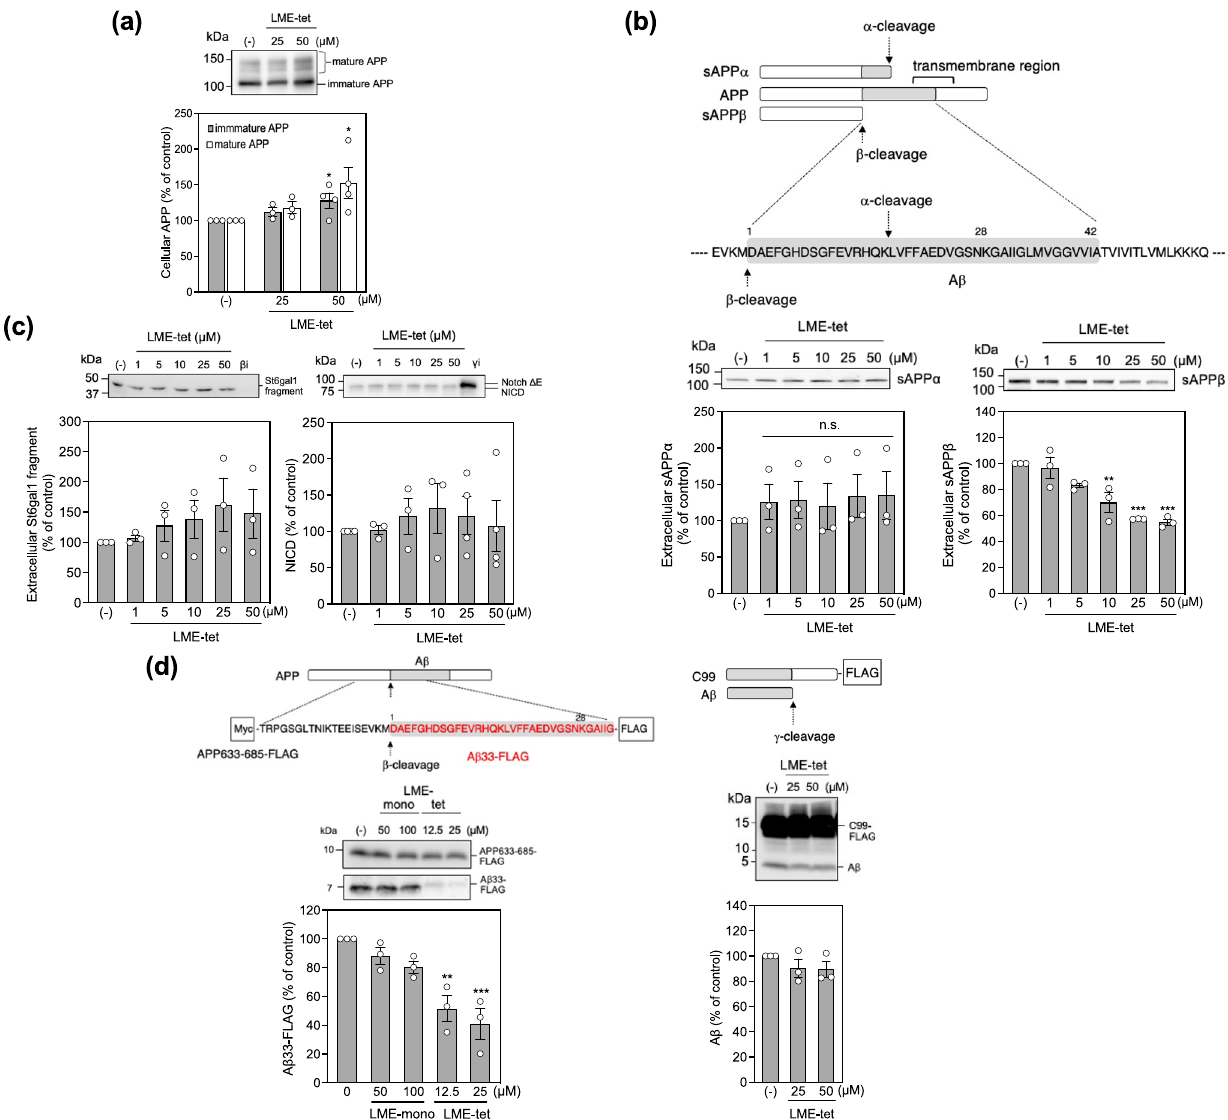
Fig. 4 LME-tet speci fi cally inhibits β -secretase to block production of A β . a Effect of LME-tet on APP production. 7WD10 cells were treated with vehicle control or LME-tet at the indicated concentrations for 48 h. Cell lysates were analyzed by western blot. b Effect of LME-tet on production of extracellular sAPP α and sAPP β Schematic showing α - and β -cleavage sites (top). 7WD10 cells were treated as in ( a ) and sAPP α and sAPP β in culture medium were analyzed by western blot (bottom left and right panels, respectively). a , b APP and sAPP α were detected using anti-APP antibody 6E10, and sAPP β was detected using anti-sAPP β antibody. Data are graphed as the percentage of the control value, showing the mean ± SE; n = 3 – 4. Signi fi cance vs . vehicle was calculated by ANOVA, followed by one-sided Dunnett ’ s test; * P < 0.05, ** P < 0.01, *** P < 0.001. c Effect of LME-tet on β -cleavage of β -galactoside α -2,6- sialyltransferase 1 (St6gal1) and γ -cleavage of Notch Δ E. 7WD10-Notch Δ E-St6gal1 cells were treated with LME-tet at the indicated concentrations and β - secretase inhibitor II ( β i; 10 µ M) for 48 h; culture medium was analyzed by western blot using anti-St6gal1 antibody (left panel). 7WD10-Notch Δ E cells were treated with LME-tet at the indicated concentrations and γ -secretase inhibitor DAPT ( γ i; 10 µ M) for 48 h; cell lysates were analyzed by western blot using anti-Myc antibody (right panel). Data are graphed as the percentage of the control value, showing the mean ± SE; n = 3 – 4. Signi fi cance vs . vehicle was calculated by ANOVA, followed by one-sided Dunnett ’ s test. d Effect of LME-tet on β - and γ -secretase activities in vitro. Schematics showing β - and γ - cleavage sites/products and FLAG-tag locations (top left and right panels, respectively). Puri fi ed FLAG-tagged APP fragment (APP633 – 685-FLAG) with N-terminal Myc and C-terminal FLAG tags was incubated with β -secretase and LME-tet/LME-mono at the indicated concentrations for 4 h (left). FLAG- tagged C99 was incubated with γ -secretase and LME-tet at the indicated concentrations (right). A β 33-FLAG (left) and A β (right) were measured by western blot using anti-A β antibody 82E1. APP633 – 685-FLAG (left) was measured by western blot using anti-A β antibody 6E10. Graphs show the mean ± SE, n = 3. Signi fi cance vs . vehicle was calculated by ANOVA, followed by one-sided Dunnett ’ s test; ** P < 0.01, *** P <